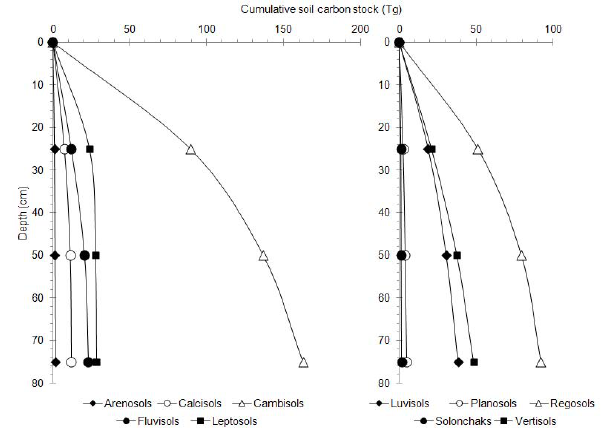
Fig. 4. Cumulative soil organic carbon stock in depth for each soil class.